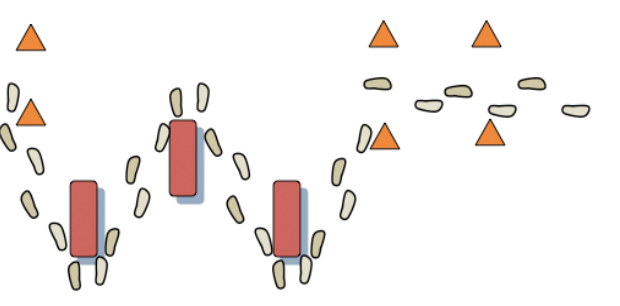
Figure 5-28. Bag Routine – Forward and Backpedal